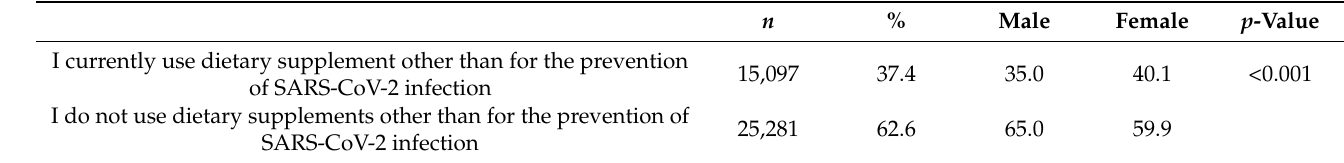
Table 5. The prevalence of dietary supplement usage other than for the prevention of SARS-CoV-2 infection. n % Male Female